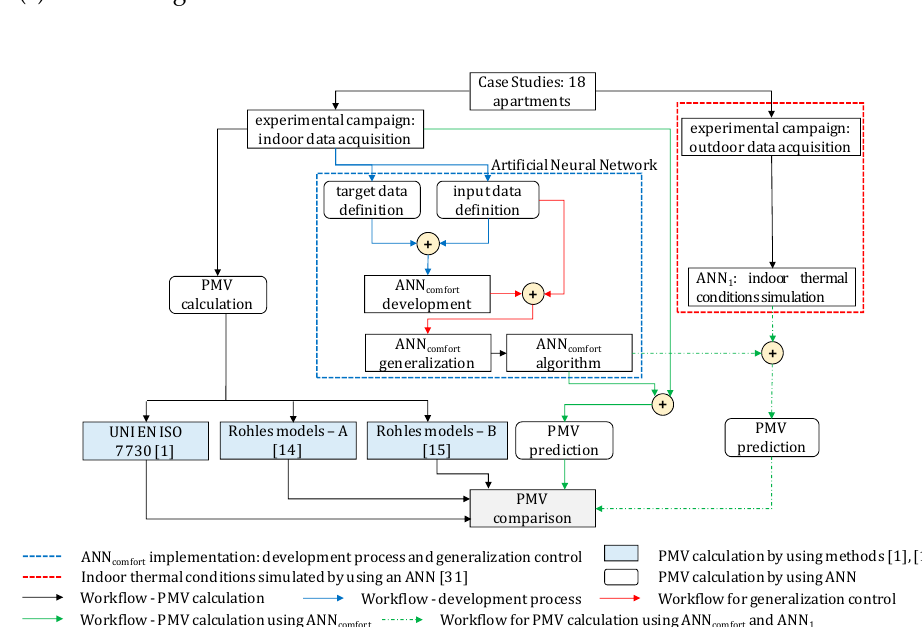
Figure 1. Research procedure adopted for the development of Artificial Neural Network able to simulate the main thermal comfort index (PMV).